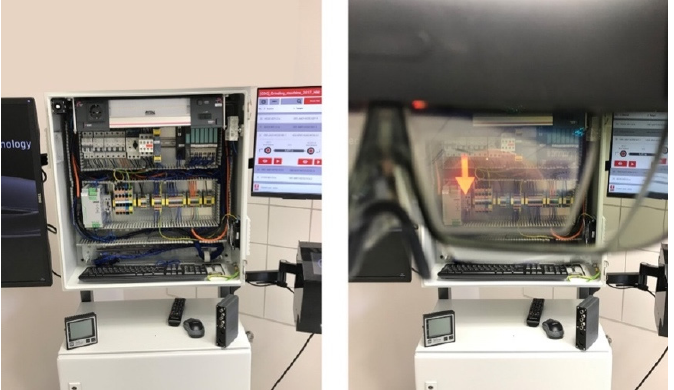
Figure 5. Actual view of a control cabinet; left side: control cabinet seen without the glasses; right side: control cabinet as seen through the right lens of the AR glasses, with virtual red arrow visible (the top grey field is the glasses frame and to the left one can see the glasses bridge and nose pads). Photographs: Szajna A.